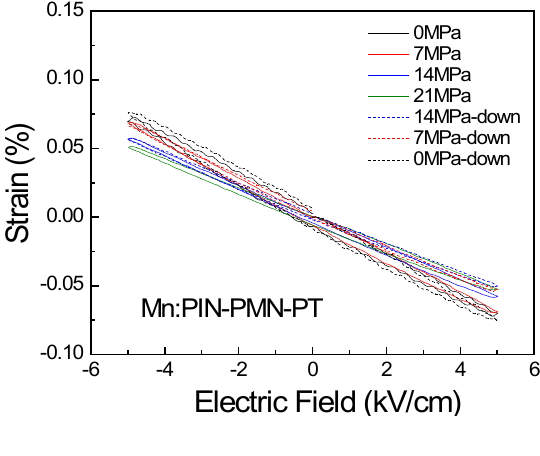
Figure 11. Bipolar strain behavior for Mn:PIN-PMN-PT crystals under different prestress levels. Reprinted with permission from [85]. Copyright 2013 AIP